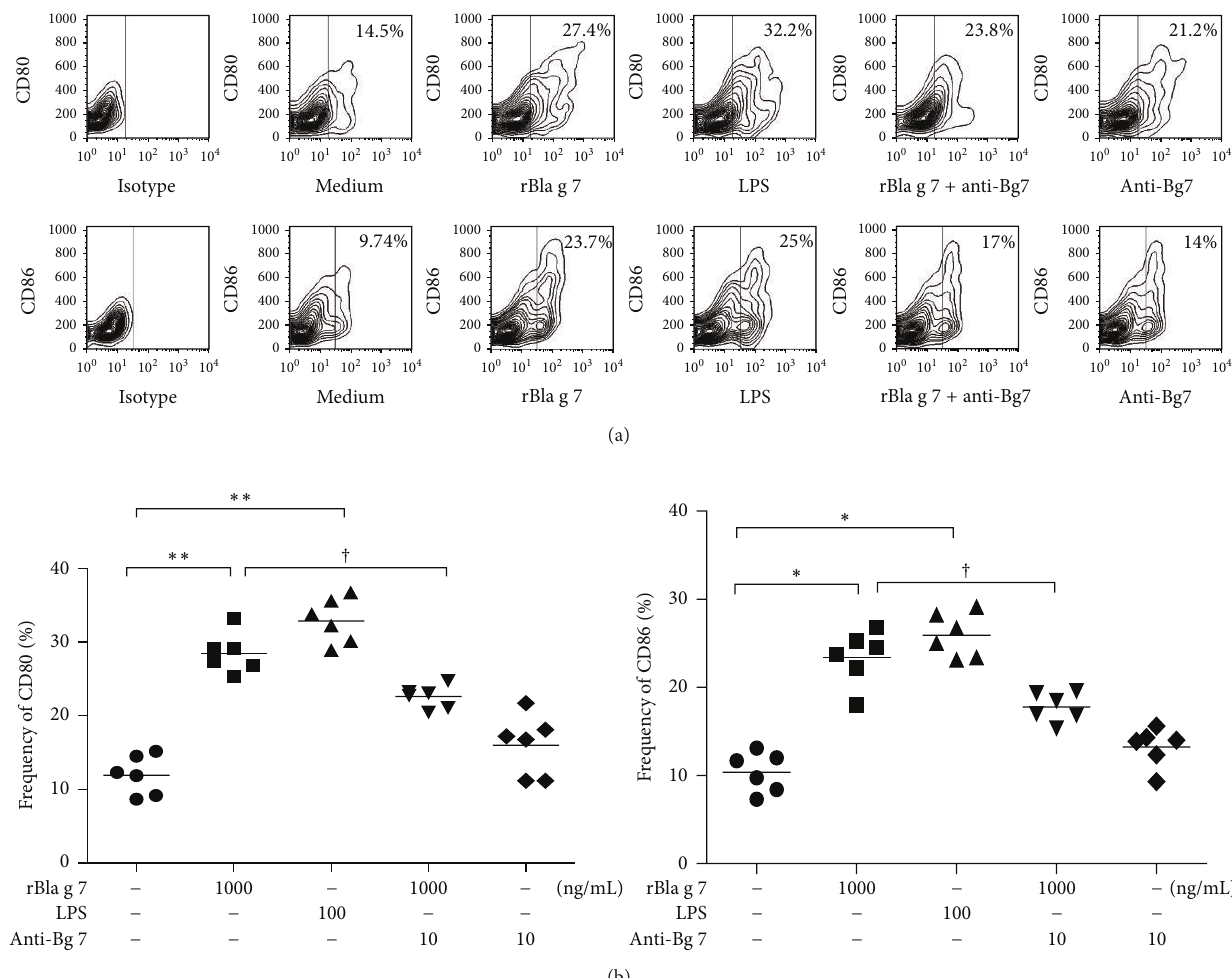
Figure 2: rBla g 7 induced expression of CD80 and CD86 in dendritic cells (DCs)s. DCs were incubated with rBla g 7 (1000ng/mL) or LPS (100ng/mL) for 48 h at 37 ∘ C before being analysed by flow cytometry. (a) Numbers within the large gated regions indicate the percentage of matured cells among total cells. (b) The mean ± SEM data represented the percentage of CD80+ or CD86+ DCs for four separate experiments. ∗ 𝑃 < 0.05 in comparison with medium alone control. † 𝑃 < 0.05 compared with the response to the corresponding uninhibited